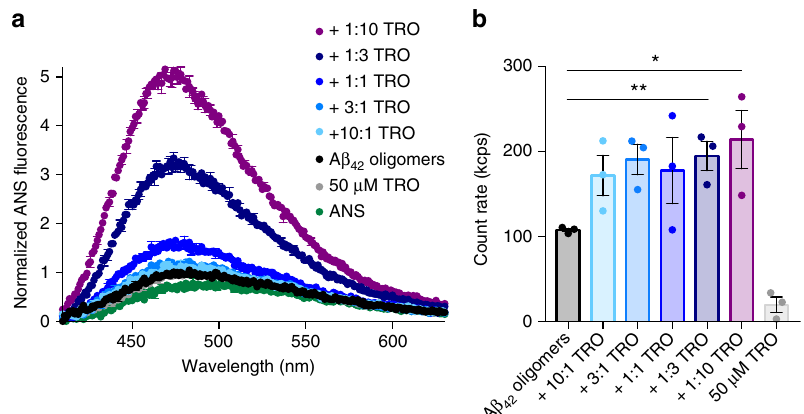
Fig. 4 Trodusquemine modi fi es the biophysical properties of A β 42 oligomers. a The binding of 15 µ M ANS to 5 µ M A β 42 oligomers after incubation for 1 h at 20 °C in the absence (black) and presence of 10:1, 3:1, 1:1, 1:3 and 1:10 ratios (light blue to purple) of A β 42 -to-trodusquemine. Spectra were normalized to the intensity of ANS fl uorescence for A β 42 oligomers. Mean ± s.e.m. of duplicate samples. Data shown are representative of